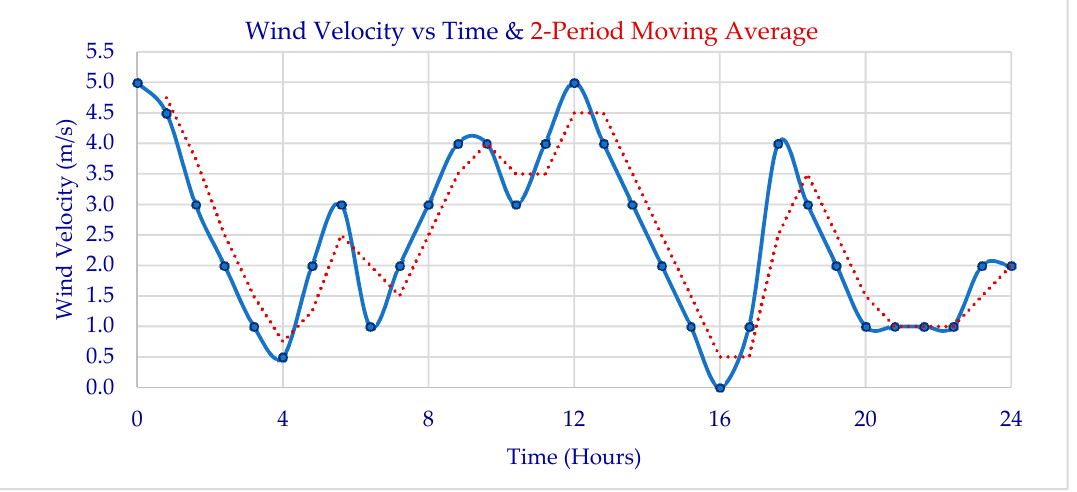
Figure 4. Wind Velocity during 24 h.